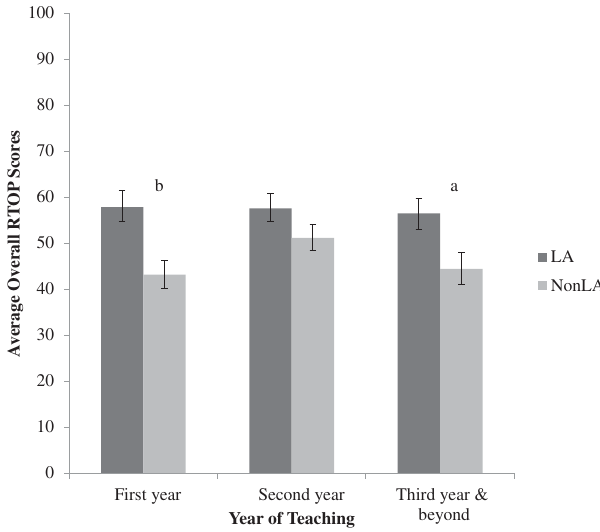
FIG. 4. Overall RTOP scores disaggregated by teachers ’ experience. Error bars represent plus and minus 1 standard error on the mean. (a) p ¼ 0 . 01 , (b) p ¼ 0 . 002 .